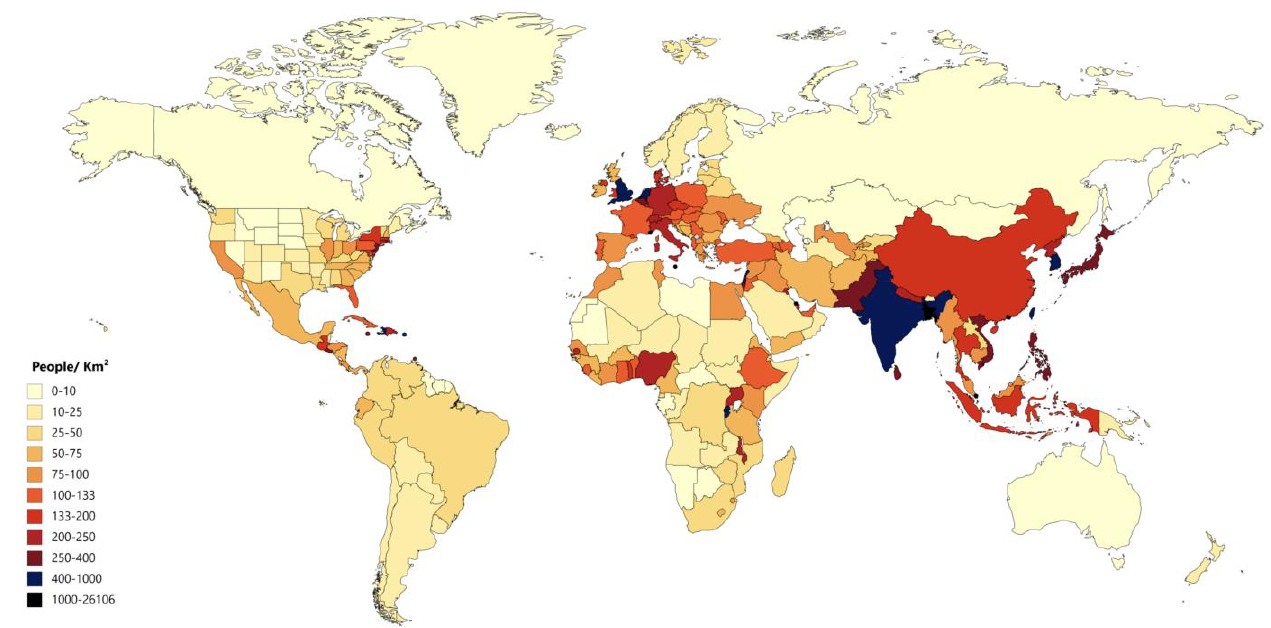
Figure 5. Global population density.